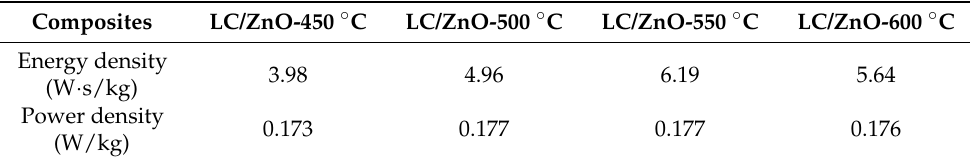
Figure 7. GCD curves at 0.1 A/g of the LC/ZnO composites. Table 1. Energy density and power density of LC/ZnO composites.